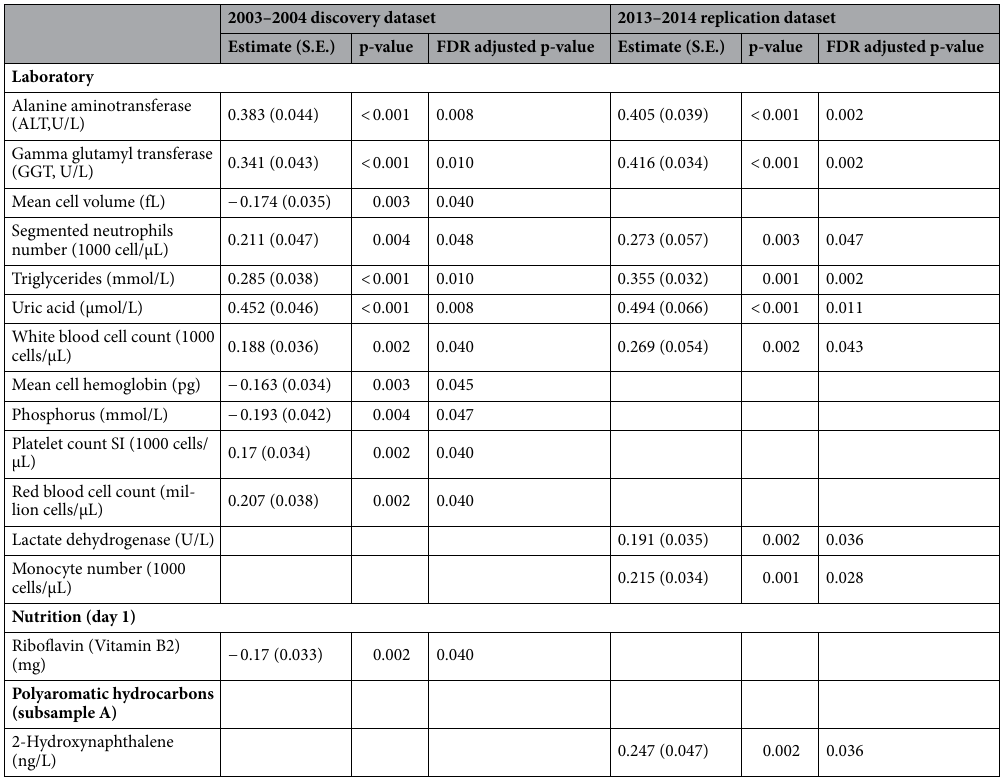
Table 2. Variables significant in multivariable linear regressions adjusted for age, sex, race/ethnicity, household smoking and poverty income ratio in 2003–2004 and 2013–2014 survey datasets.